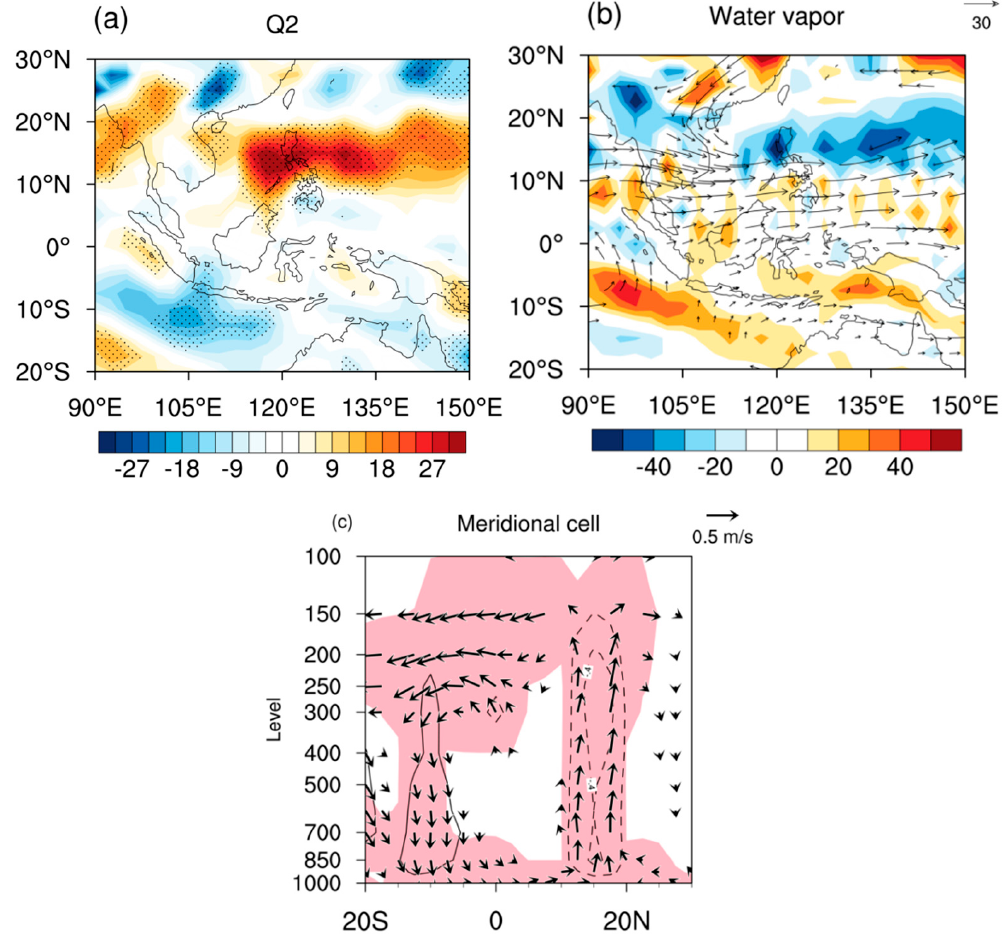
Figure 7. Linear regression slopes of JJA–mean ( a ) (cid:104) Q 2 (cid:105) (shaded; W m − 2 ), ( b ) water vapor flux (vector; kg m − 1 s − 1 ) and divergence (shaded; 10 − 7 g m − 2 s − 1 ) at each grid of TEIOWP, and ( c ) vertical velocity (contour interval; 100 − 1 Pa s − 1 ) and wind (vector; meridional component, m s − 1 ; vertical component, Pa s − 1 , multiplied by -100; the wind speeds less than 0.1 m s − 1 are not shown) averaged over 110 ◦ –140 ◦ E at each grid onto the inverted DJF(–1)–mean Niño3.4 index for the period of 1958 to 2018. Note that the units of the Y -axis in (c) is hPa. The black dotted area in ( a ) denotes the Q 2 anomalies exceeding the 95% significance level, respectively. The shaded area in ( c ) denotes the wind anomalies exceeding the 95% confidence level; the zero contours are omitted. Only the water vapor flux anomalies significant at the 95% confidence level are plotted in ( b ).